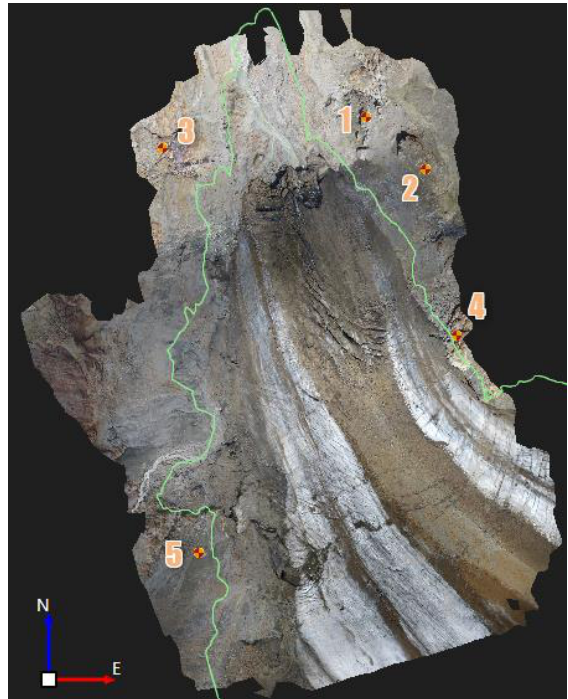
Figure 1. Distribution and position of the DPC-GCPs with respect to the glacier, whose borders are identified by the green line.